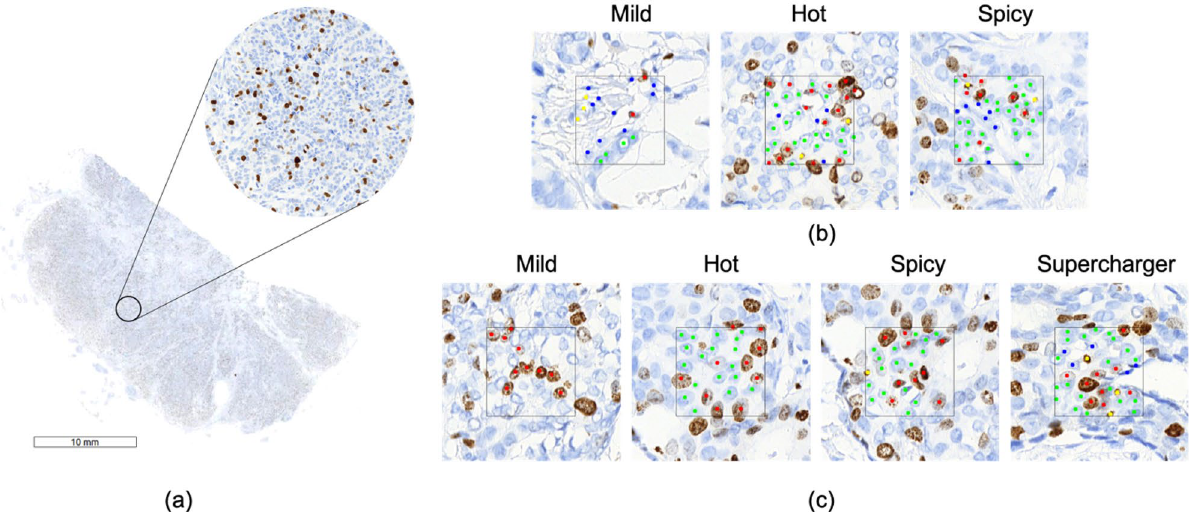
Figure 1. ( a ) One Ki67 stained WSI where one tumour region is zoomed in. ( b ) Example images of each level in Pilot competition. ( c ) Example images of each level in Main competition (Red: Positive Tumour or PT; green: Negative Tumour or NT; yellow: Positive Non-Tumour or PNT; blue: Negative Non-Tumour or